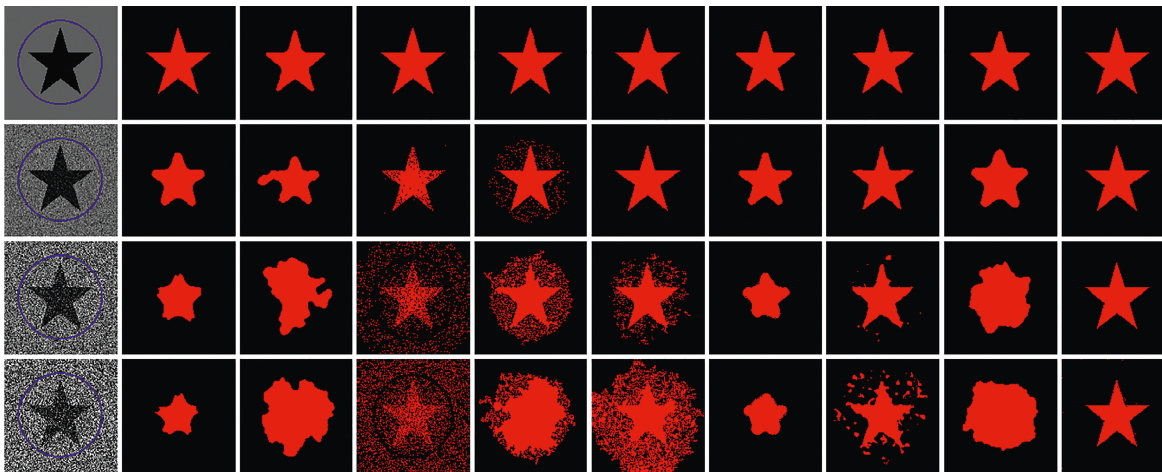
Figure 4: The comparison results on a set of noisy synthetic images with increasing intensity of Gaussian noise. The first column: input image with initial contour, from the top row to the bottom row, the variances of Gaussian noise are 0, 0.01, 0.05, and 0.1, respectively. The second to the ninth columns are the segmentation results by using GAC, LSR, CV, FTC, LBF, LAC, LPFE, NFT, and our method, re- spectively. The parameters used in this group of experiments are σ � 1 . 5 and κ � 1 . 3. Table 1: Region overlap metrics of different algorithms corre- sponding to Figure 4 numbered in order from up to